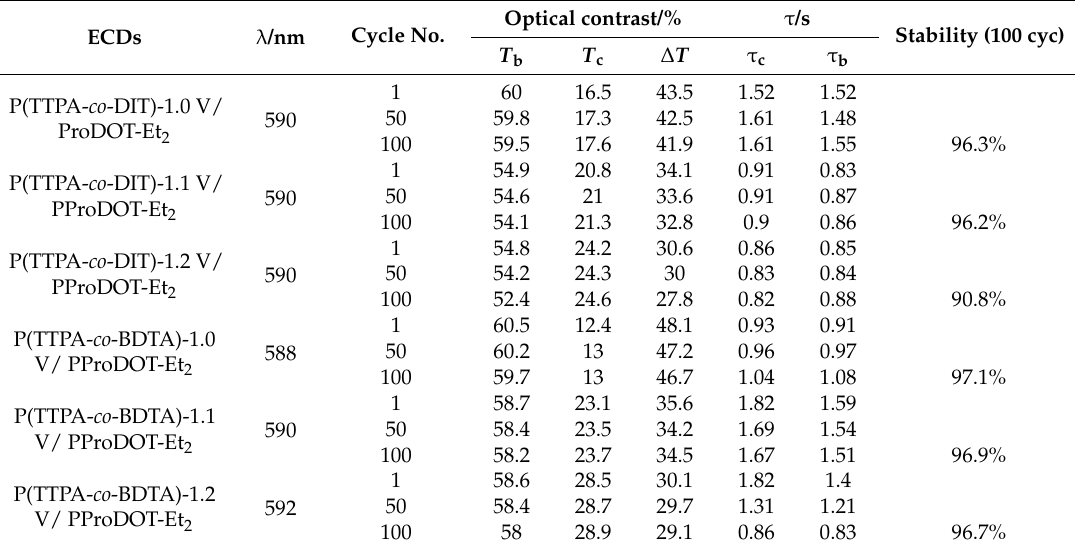
Table 6. Color–bleach switching time of ECDs.